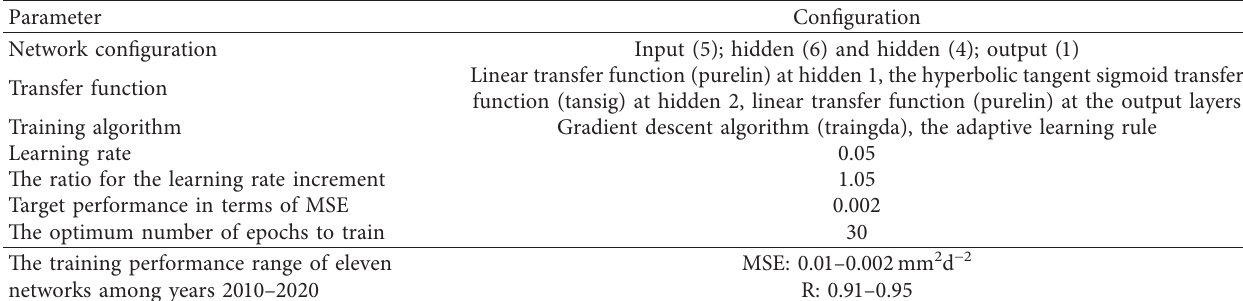
Table 3: ANN parameters and configuration for future rainfall forecasting.